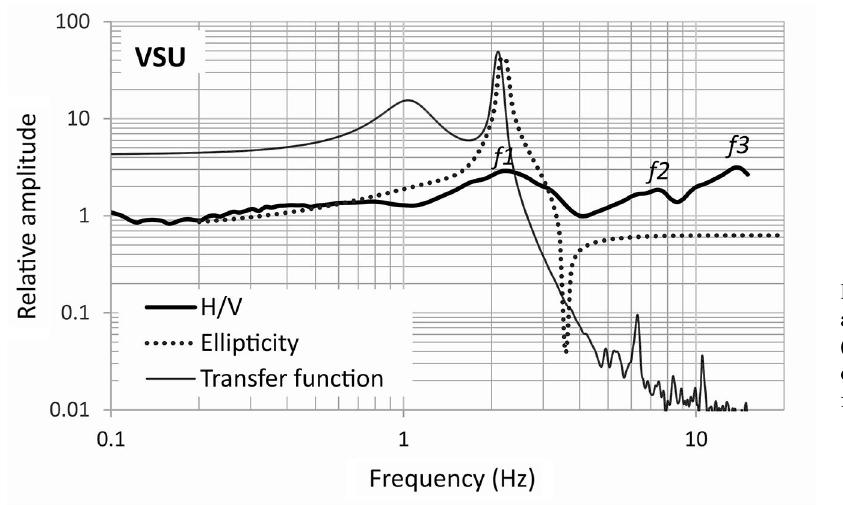
Fig. 3. Curves of HVSR, ellipticity and transfer function for the Vasula (VSU) station . f 1 ... f 3 – frequencies of HVSR peaks pointed in Table 1 for the VSU